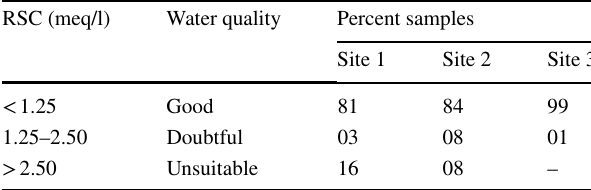
Table 14 Groundwater quality based on RSC (Richards